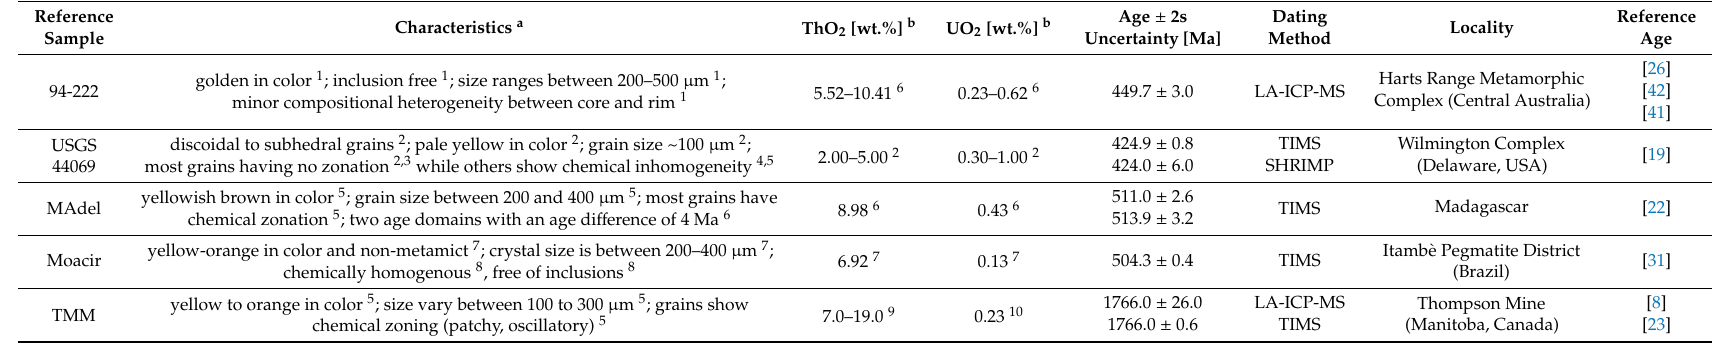
Table 1. Summary of all five analyzed monazite reference samples. a,b : References for the characteristics, ThO 2 and UO 2 : 1 : [41], 2 : [19], 3 : [29], 4 : [10], 5 : observation based on this study, 6 : [26], 7 : [20], 8 : [16], 9 : [8], 10 :